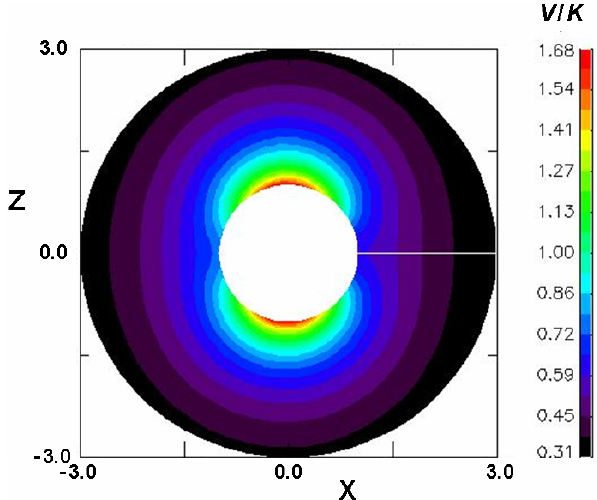
Fig. 10. Normalized potentials for the case R =1.0, α =1.2, φ b =23.9, Y=0.